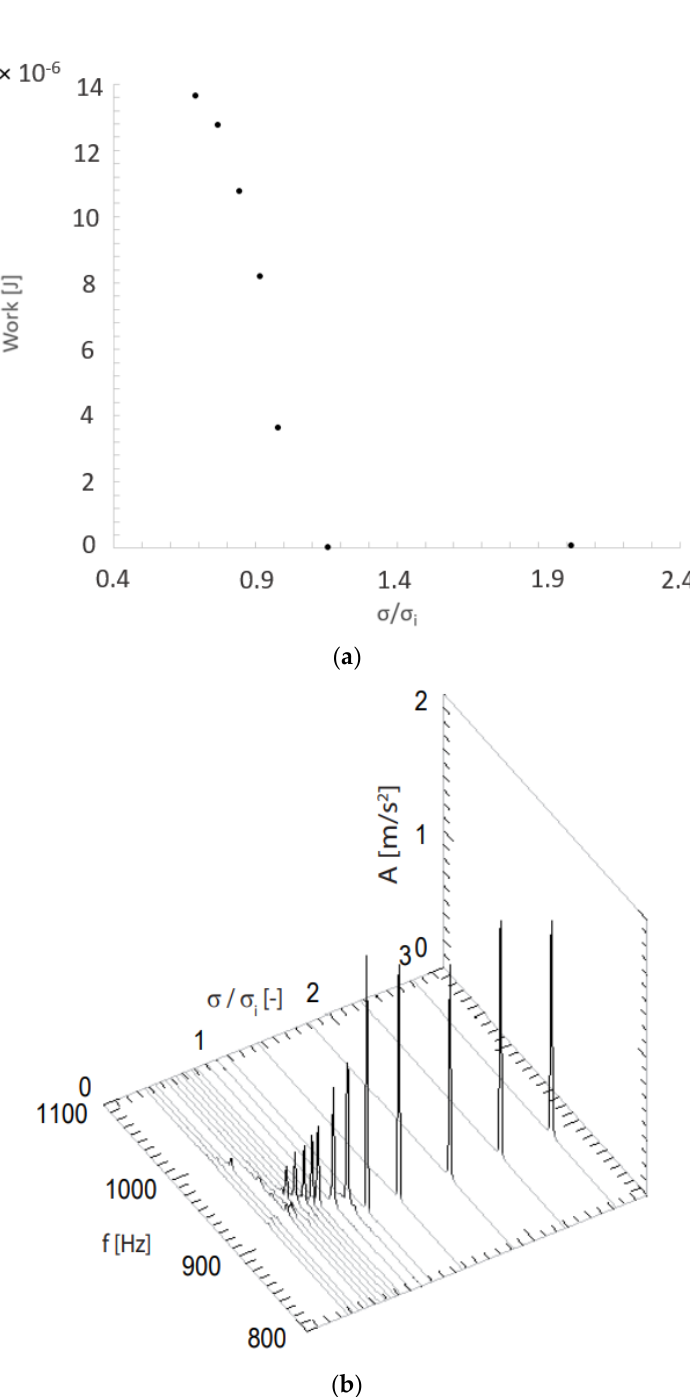
Figure 8. Computed modal work ( a ) and acceleration vibration amplitude ( b ) measured by Ausoni et al. [6] as a function of cavitation level.